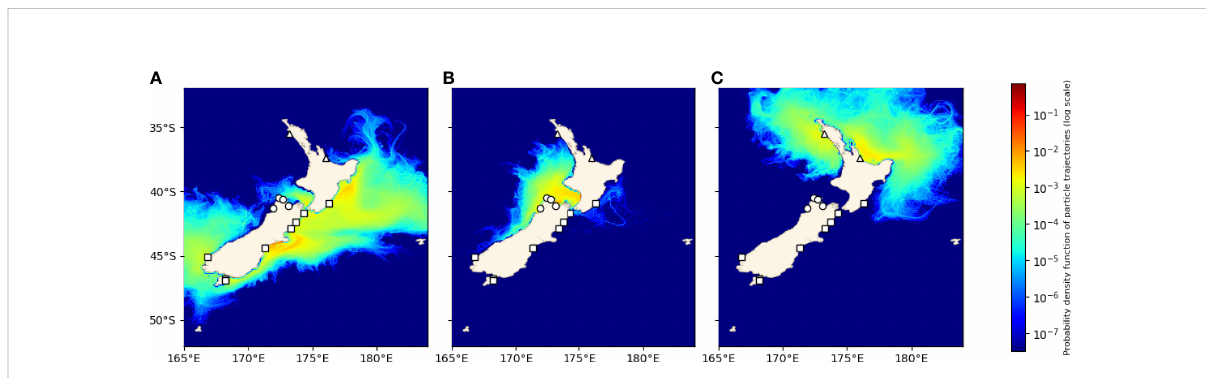
FIGURE 6 Probability densities of trajectories during the settlement competency period (3-6 weeks) for particles released from each cluster as predicted by particle tracking experiments. (A) Fiordlands, Horseshoe Bay, Big Glory Bay, Timarau, Gore Bay, Kaikoura, and Cape Campbell (squares), (B) Little Wanganui River, Westhaven, Fletchers Beach, and Tasman Bay (circles), (C) Opononi and Maunganui (triangles).